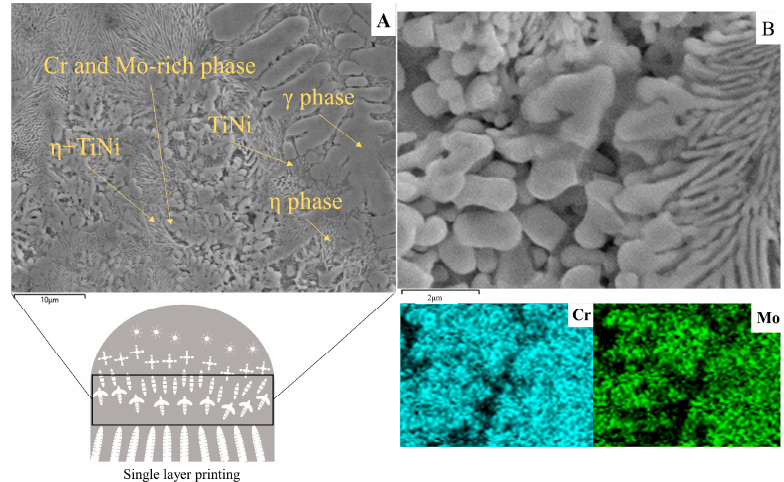
Figure 6. EDS scan single-layer sample element composition. ( A ) Top equiaxed crystal, a: branches of equiaxed crystals. b: Matrix of the sample. ( B ) Precipitated phase at the top of the sample. c: Mark points for measuring precipitated phase elements.